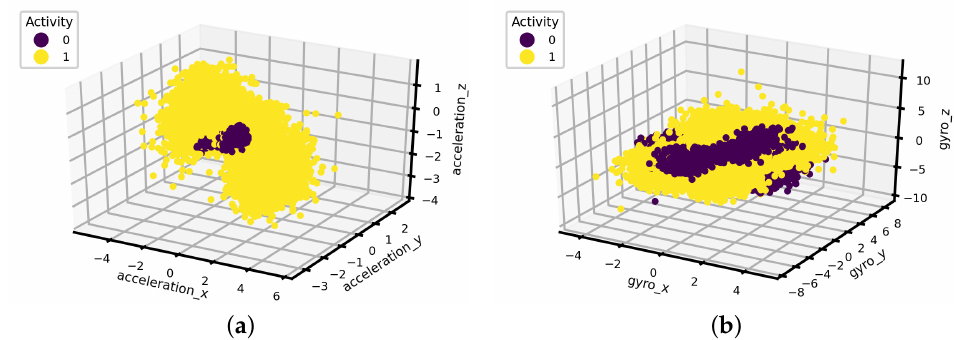
Figure 4. Three-dimensional-space analysis of smartphone sensor data. ( a ) Analysis of the accelerom- eter sensor data. ( b ) Gyroscope sensor data